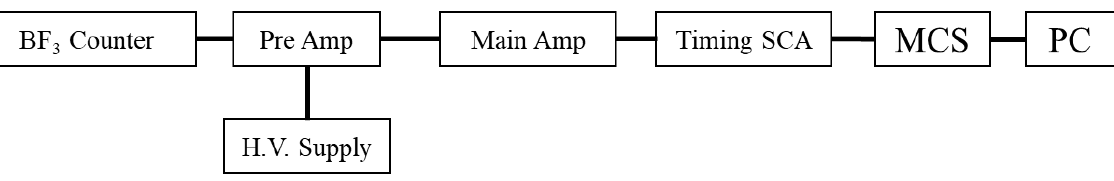
Figure 2. Measurement